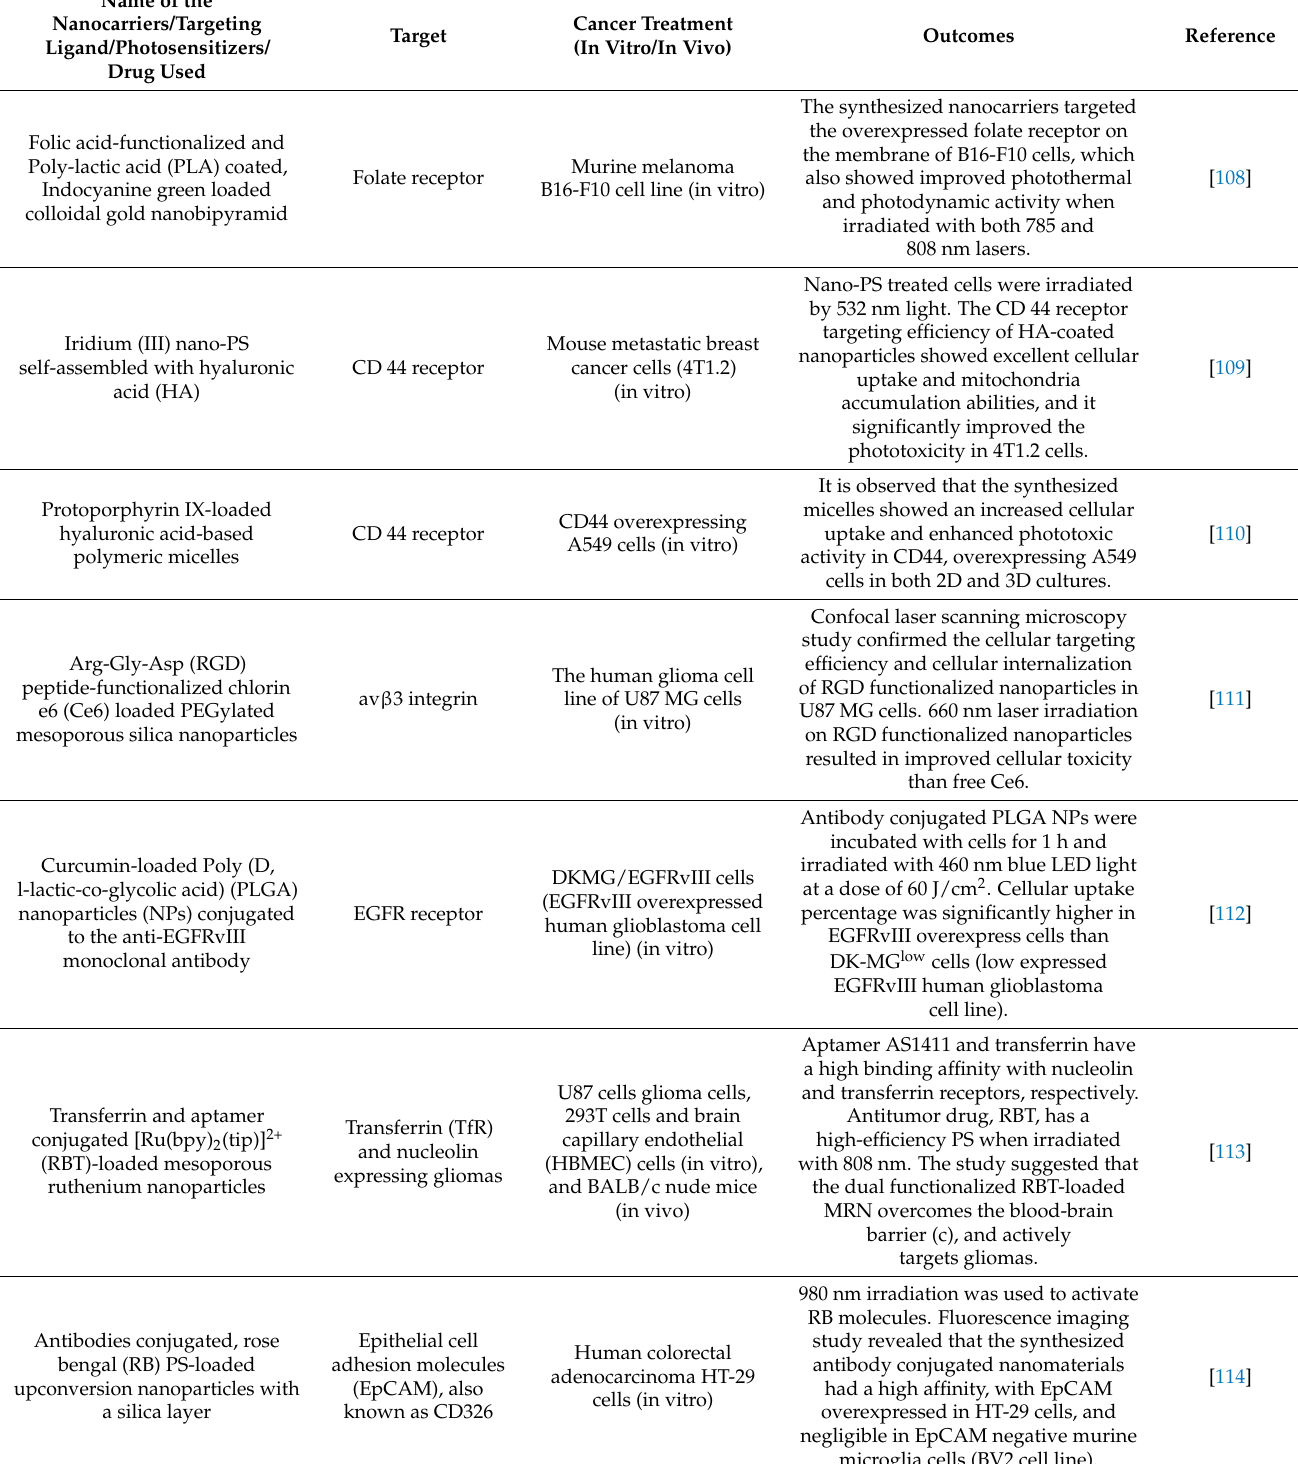
Table 2. Cancer targeting efficiency of biocompatible nanocarriers in